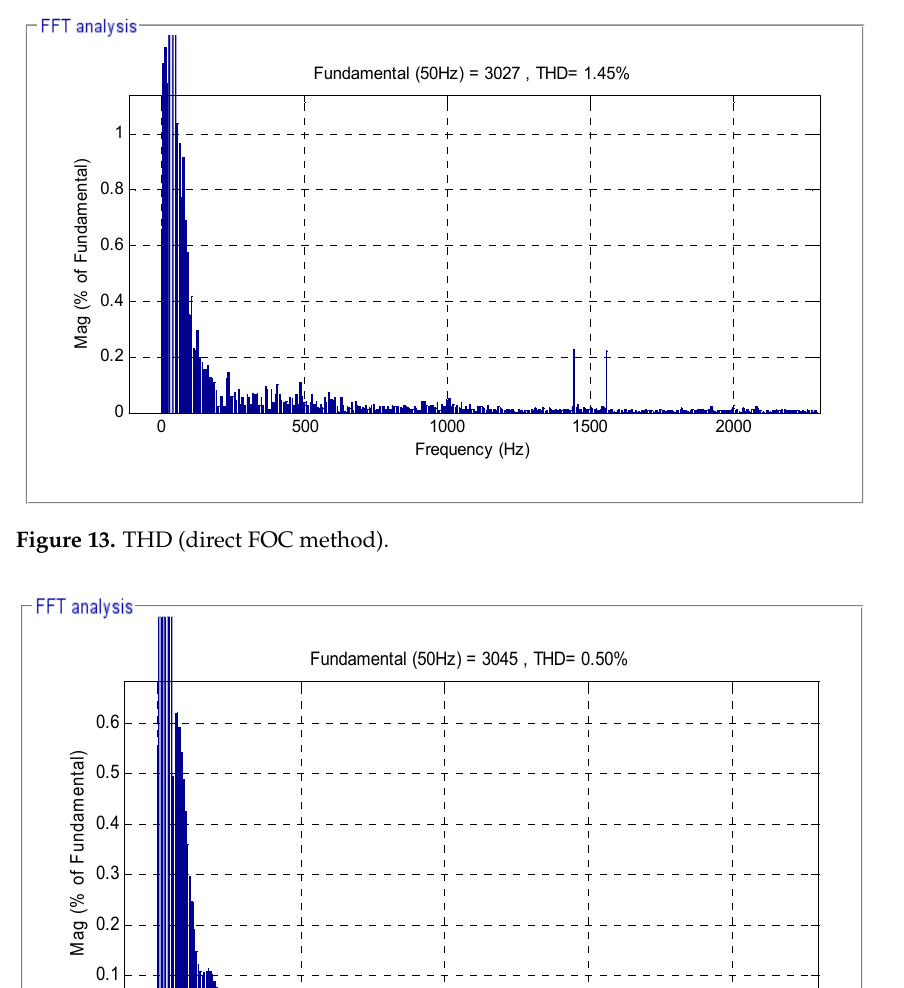
Figure 12. Zoom (Current).